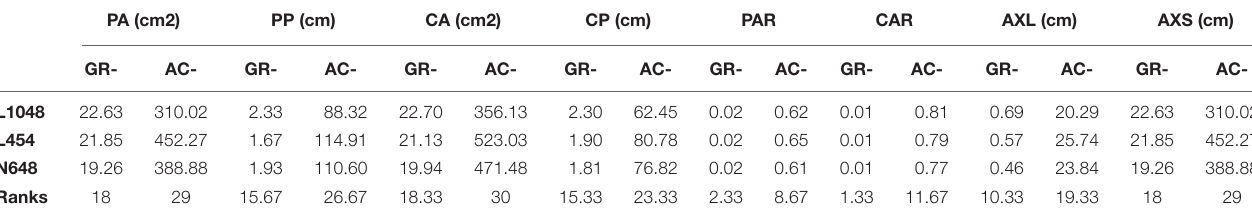
TABLE 5 | Geometry-related dynamic traits of lettuce plants.